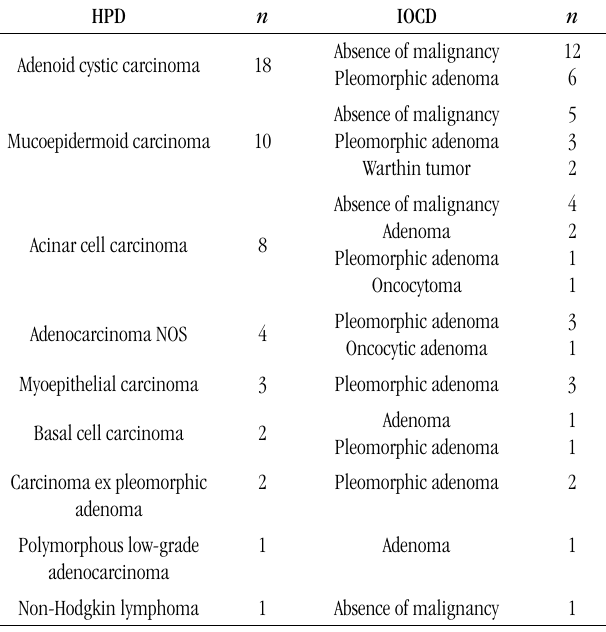
taBLE 2 – IOC in salivary gland lesions at Inca, from January 2001 to December 2012. FN cases ( n = 49)